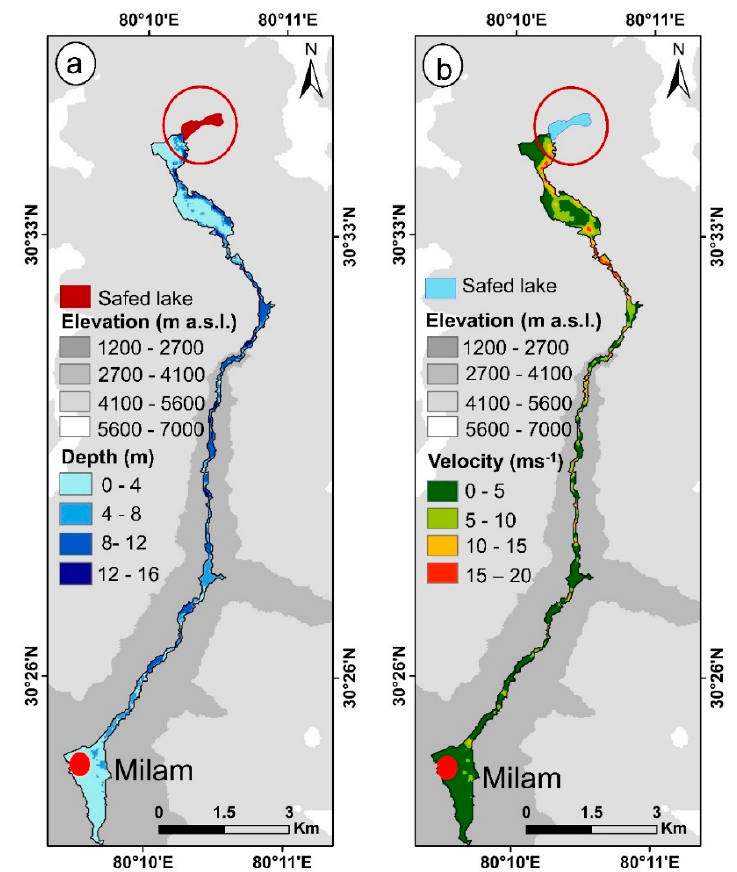
Figure 6. Spatially distributed plots of ( a ) inundation depth (in m) and ( b ) flow velocity (m s − 1 ) along the flow channel in a worst-case scenario from the lake to Milam village (Scenario 1).